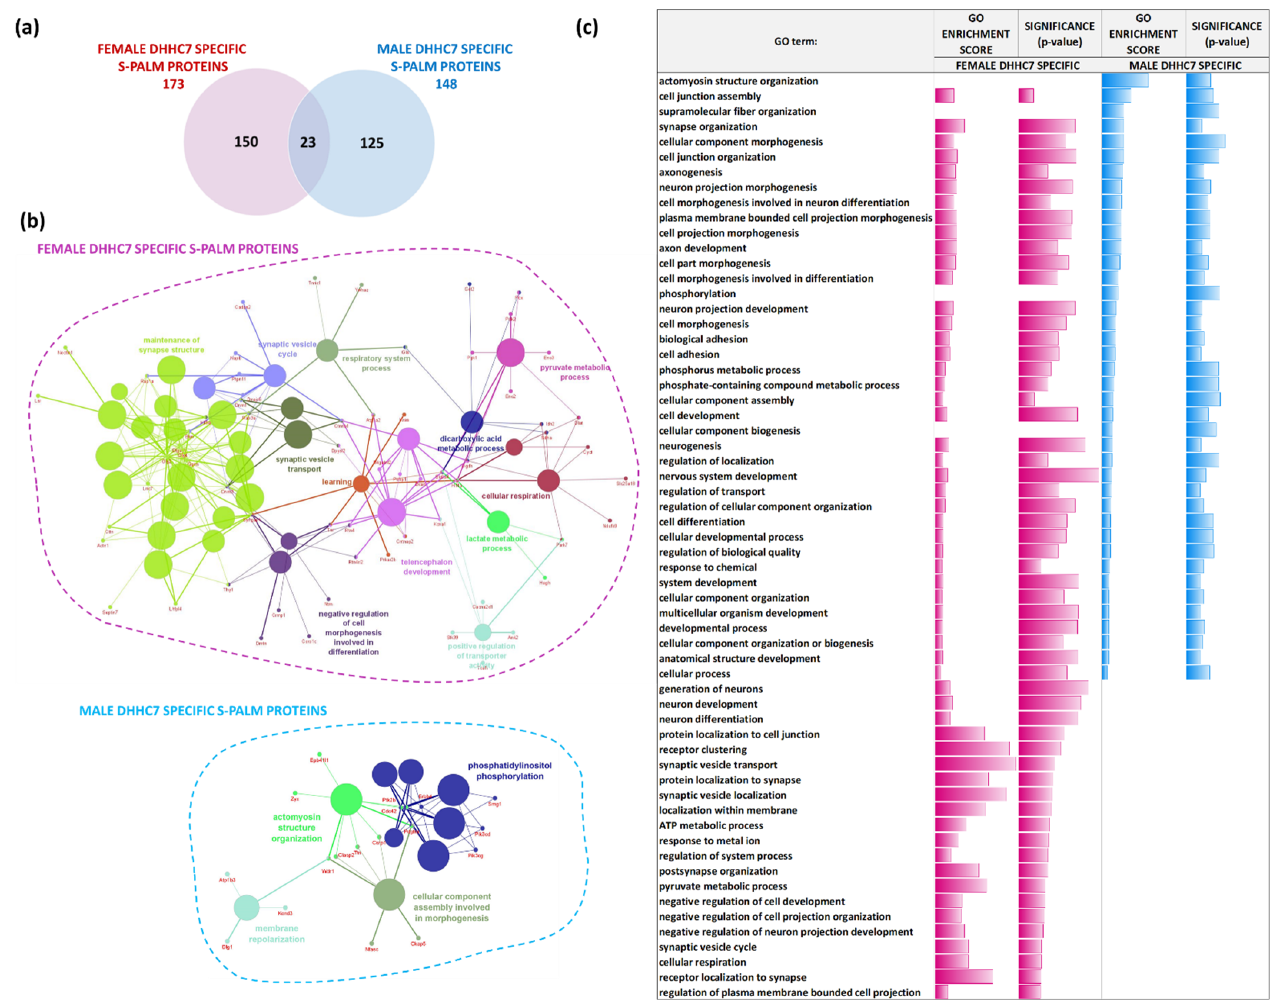
Figure 8. Analysis of female synaptic proteins regulated by DHHC7 using the Gene Ontology biological processes database and the Clue Go algorithm. ( a ) Venn diagram analysis of S-PALM in female WT and male DHHC7 KO synaptoneurosomes. ( b ) Networks depicting interactions between enriched functional classes for male and female DHHC7 specific proteins. ( c ) Summary of all enriched GO_BP functional classes for male and female DHHC7 specific proteins. ( p < 0.05) with depicted fold change and significance of enrichment.